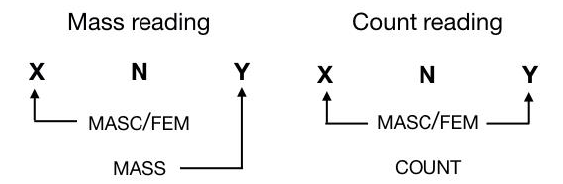
Figure 10. Asymmetric (left-hand side) and symmetric (right-hand side) feature spreading in Asturian DPs. Based on Bonet (2013: ex.